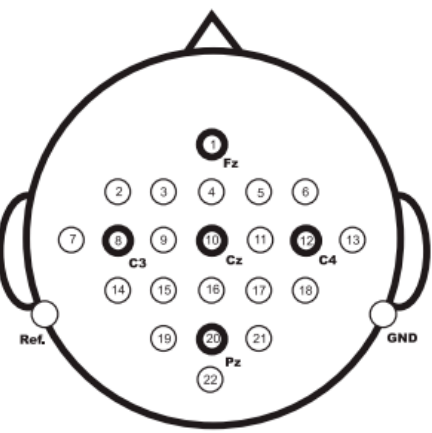
Figure 1. Electrode montage corresponding to the international 10–20 system [17].